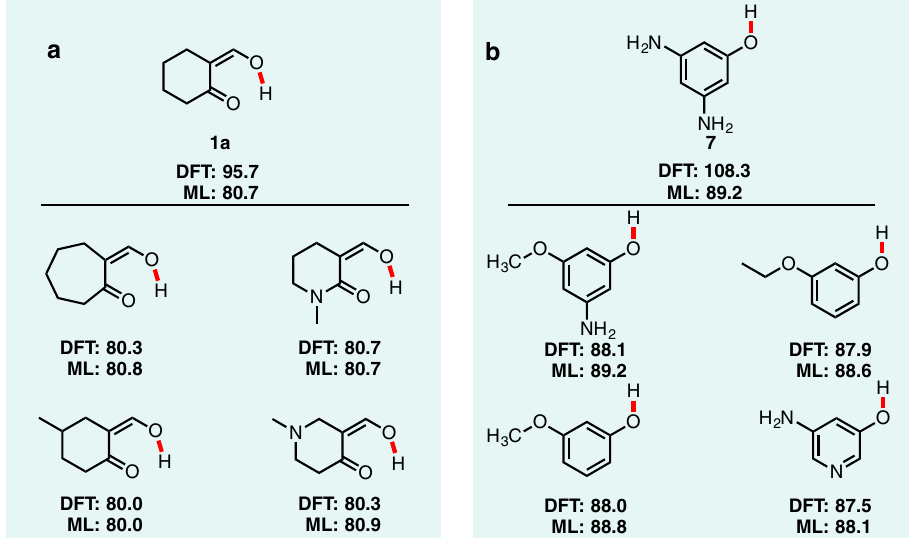
Fig. 5 Comparison of outlier calculations to training data. Similar bonds from the BDE-db database for two query bonds (top) from the BDE prediction outliers. a Bond from Fig. 4a ( 1a ). b Bond from Fig. 4d ( 7